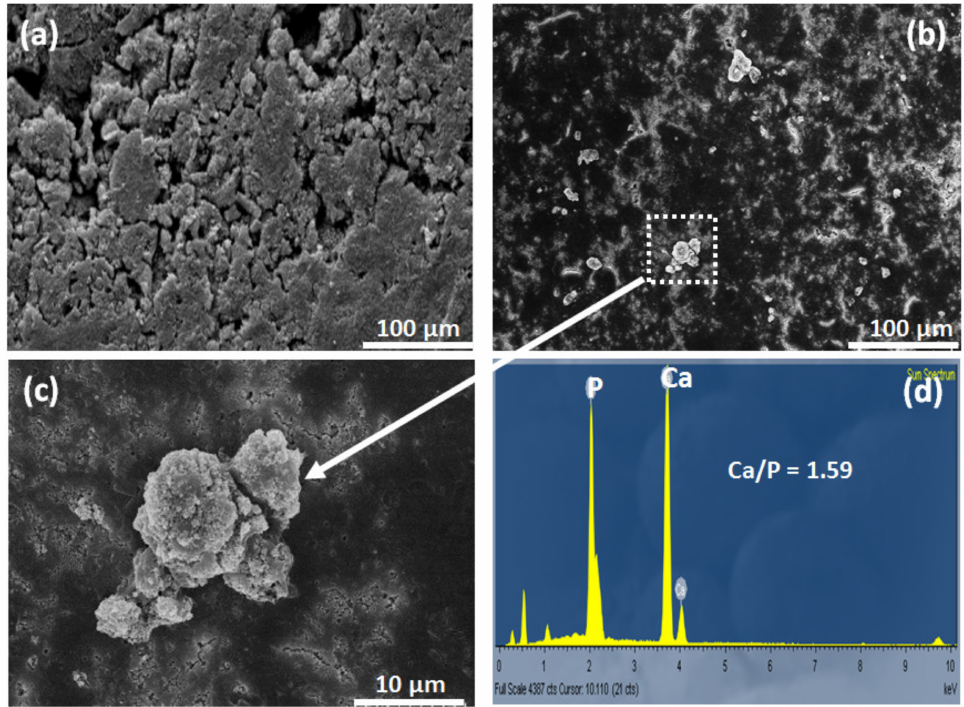
Figure 6. SEM image of THA surface before ( a ) and after ( b ) immersing the scaffolds in SBF for 7 days; ( c ) reveals the magnified view of the precipitation showing the accumulative structure of the mineral apatite particles and EDS analysis ( d